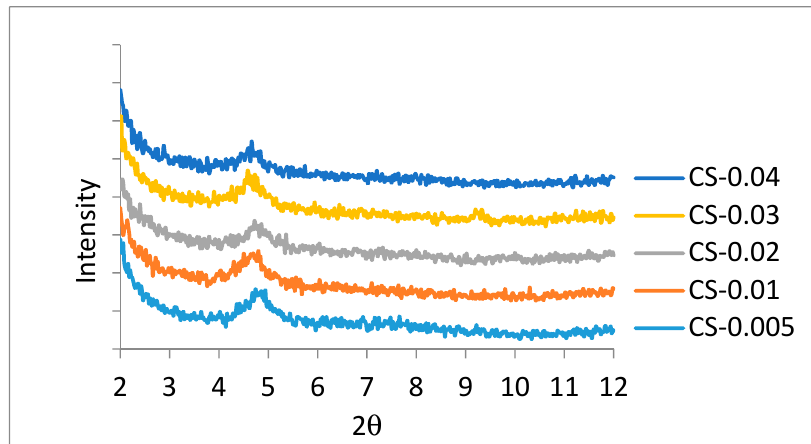
Figure 5. X-ray diffraction characteristic peaks for an MNT-filled PA membrane. The inclusion of MNT into the PA layer was done by the dispersion of a definite amount of nanoclays (0.005 wt.%, 0.01 wt.%, 0.02 wt.%, 0.03 wt.%, and 0.04 wt.%) in TMC-hexane solution. MNT-005, MNT-01, MNT-02, MNT-03, and MNT-04 refer to MNT incorporation of 0.005 wt.%, 0.01 wt.%, 0.02 wt.%, 0.03 wt.%, and 0.05 wt.%, respectively.